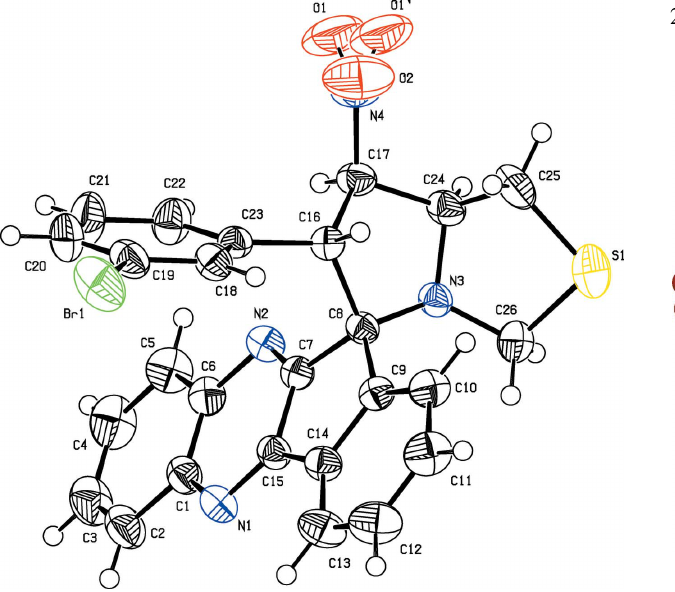
Figure 4 A centrosymmetrically related R 2 (14) ring motif formed through C— 2 H (cid:3)(cid:3)(cid:3) N hydrogen bonds, shown as dashed lines.